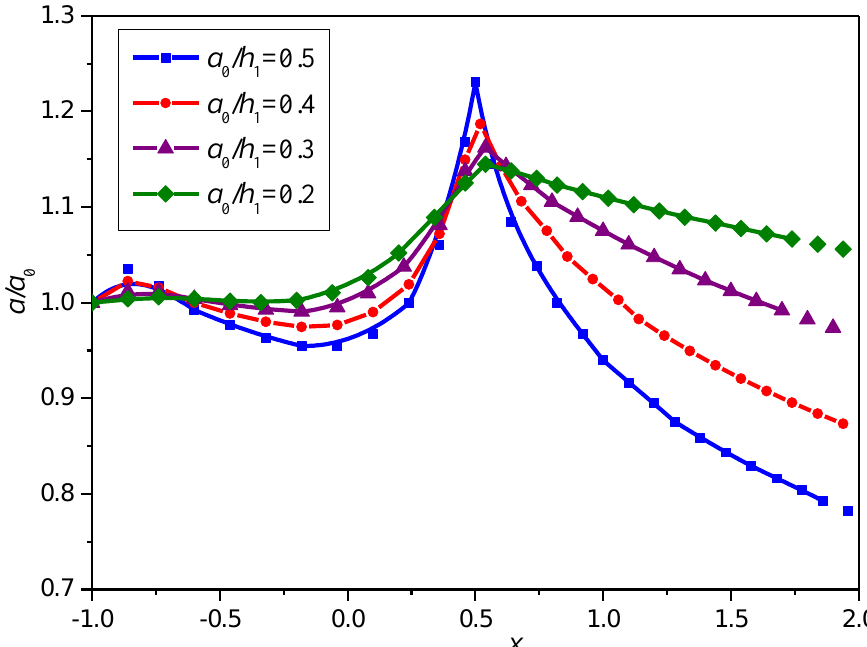
Figure 9. Variation in dimensionless amplitude for different initial amplitudes and slope height h s = 0.18.